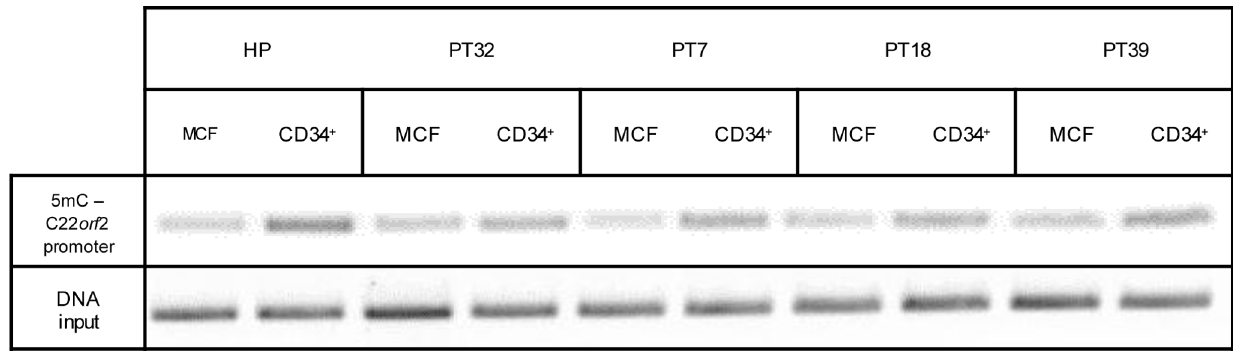
Figure 5. Cby1 reduced transcription in CD34 + cells is driven by DNA hypermethylation of C22 orf 2 promoter. PCR amplification of methylated DNA lets detect a significant increment of 5 mC a 205 bp region of C22 orf 2 promoter encompassing nucleotides 2 85 to + 120 in CD34 + cells of HP and 4 CML-CP patients compared to MCF (p , 0.05 or less). The DNA input after the isolation of 5 mC-enriched DNA was used as an internal control for PCR. 2 m g of total RNA, 10 m l of reaction buffer (1 6 ), 3 mM Mg2 + ,